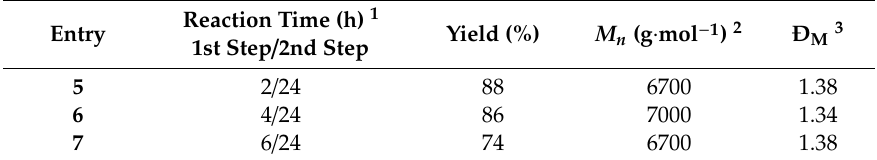
Table 2. E ff ect of oligomerization time variation on yield, M n and dispersity after a 24 h (secondary step) under